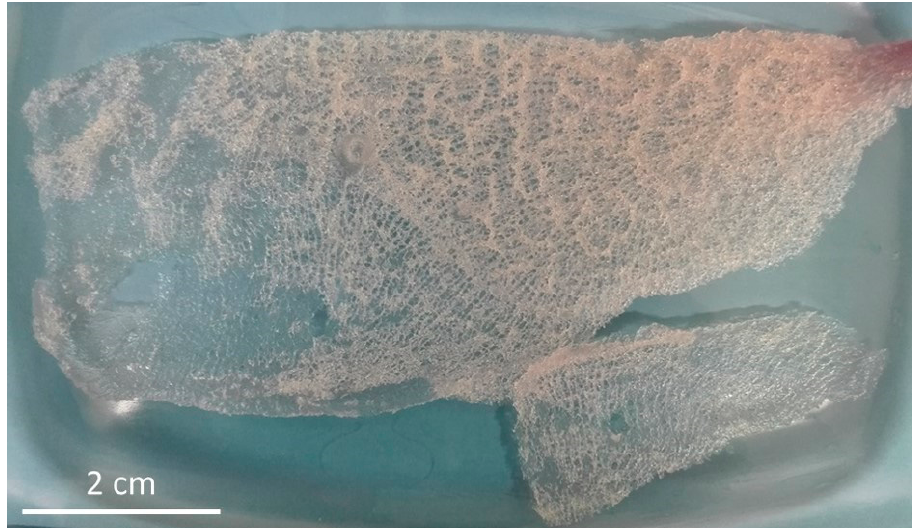
Figure 4. Translucent and mechanically flexible (see also Figure 5) chitinous skeleton of I. labyrinthus isolated after alternating use of acid and alkali treatments for 72 h at 37 °C.